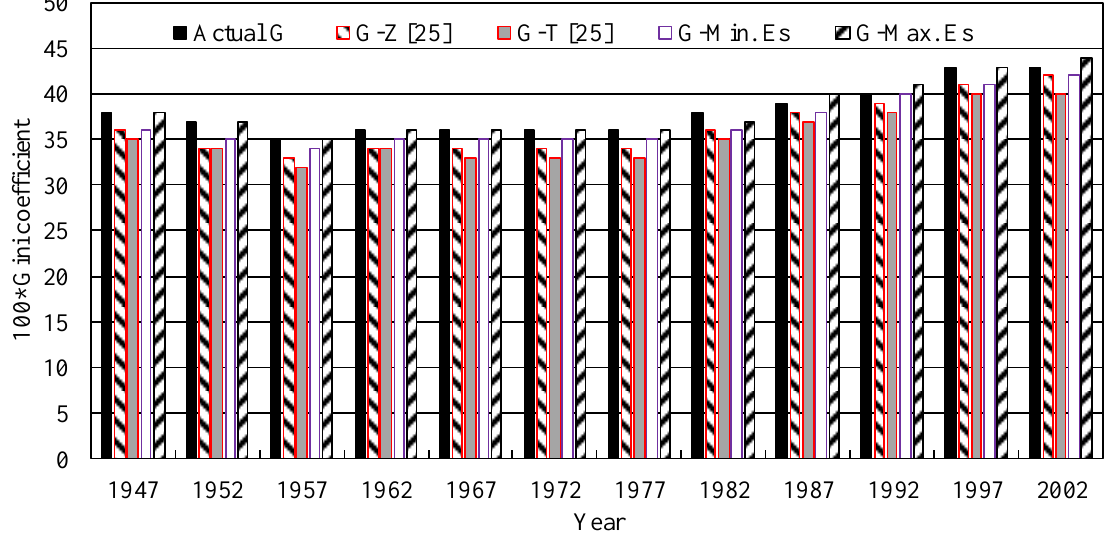
Figure 4. Comparison of Gini coefficients estimated with different methods for income quintiles of the United States in five-year intervals from 1947 to 2002. G-Z and G-T are estimates of Gini coefficient using Z-gradient and trapezoid rules [25], respectively.